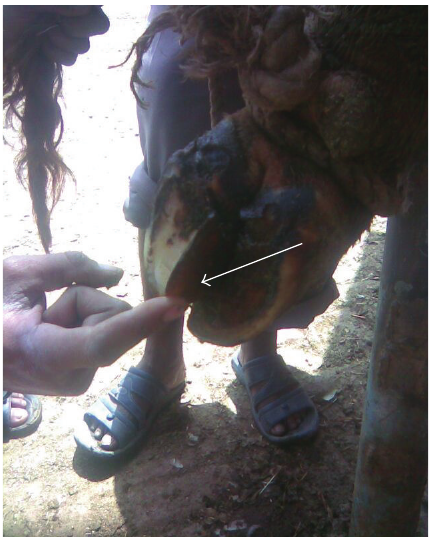
Figure 5: Underrun